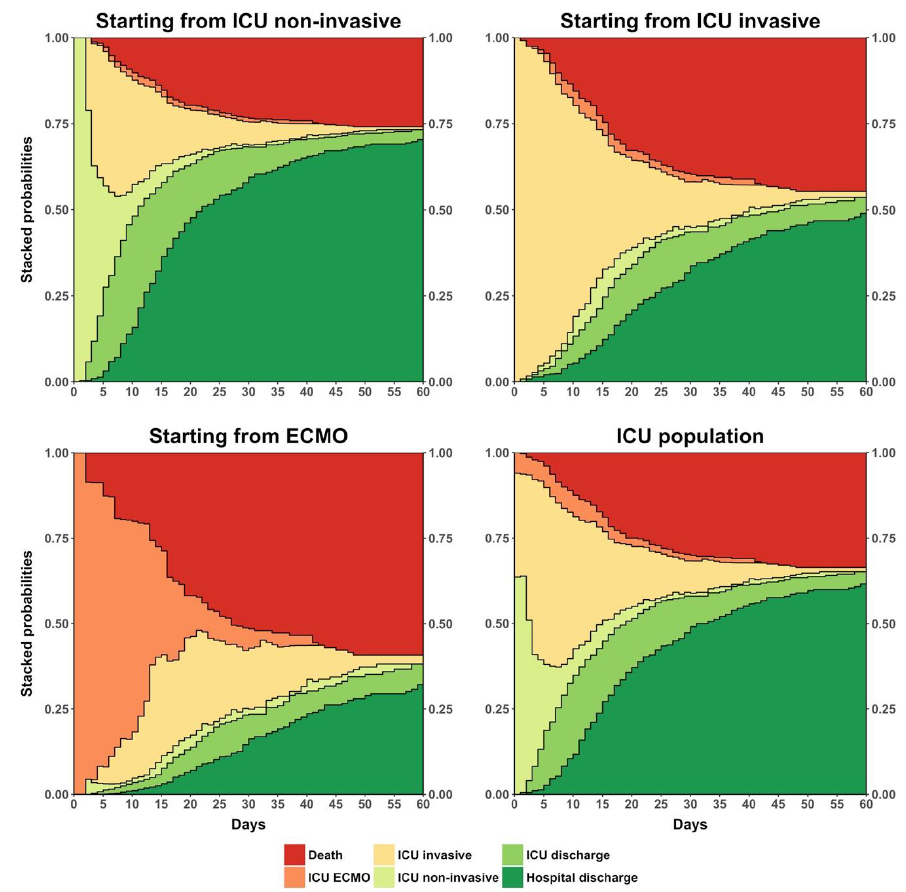
Figure 2. Stacked plots of predicted probability of state occupancy when starting from ICU non-invasive, ICU invasive, and ECMO, and in the total ICU population. Legend: ICU: intensive care unit. ICU non-invasive: in ICU without mechanical ventilation. ICU invasive: in ICU with mechanical ventilation. ECMO: extracorporeal membrane oxygenation.